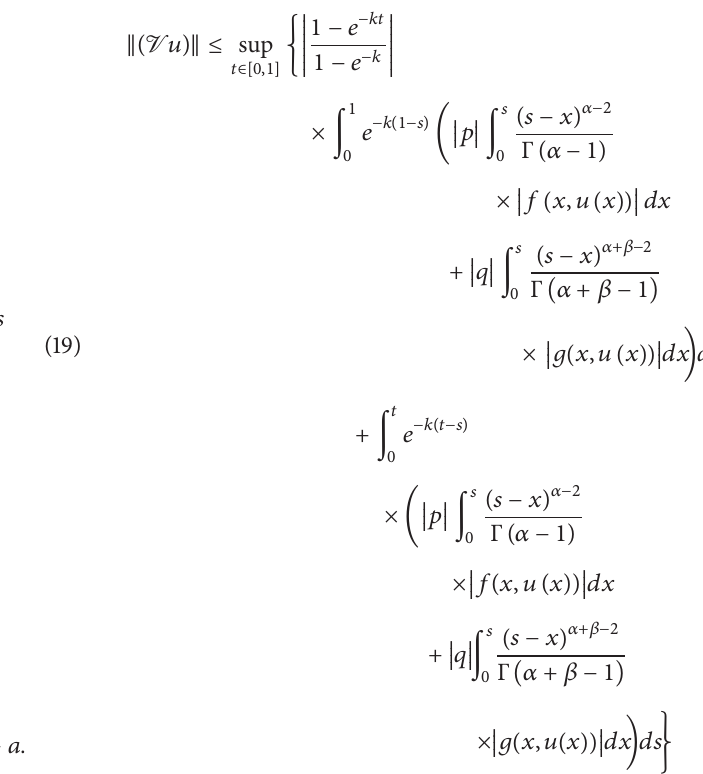
A fixed point operator V 2 : P → P for the nonlinear problem (1)–(4) is defined